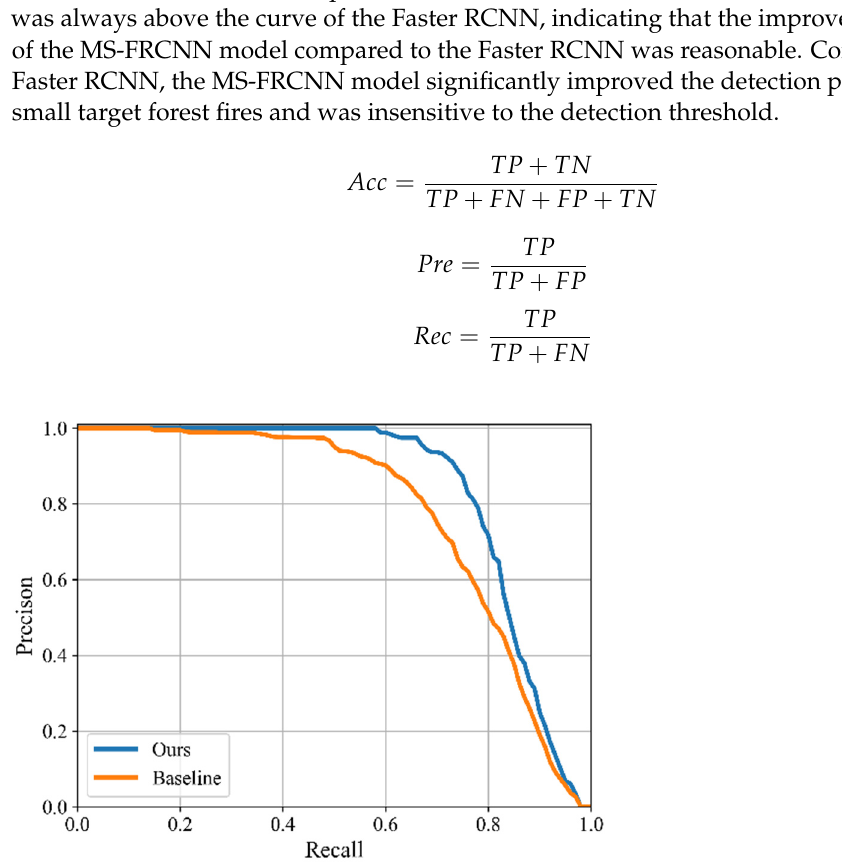
Figure 9. Precision recall curves for small target forest fire detection (Baseline is the Faster RCNN model; Ours is the MS-FRCNN model).